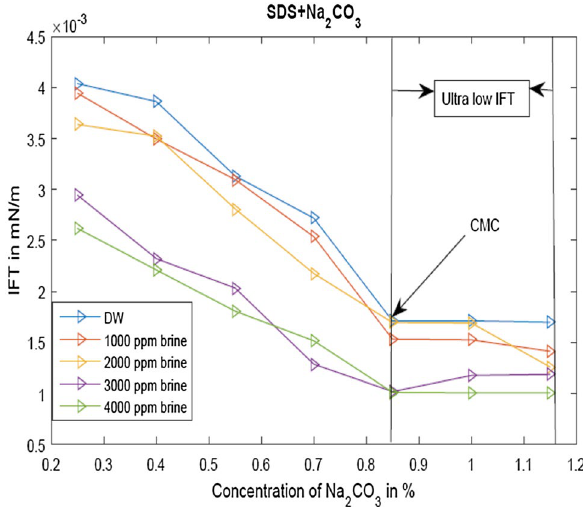
Fig. 6 IFT between NH crude and SDS + Na